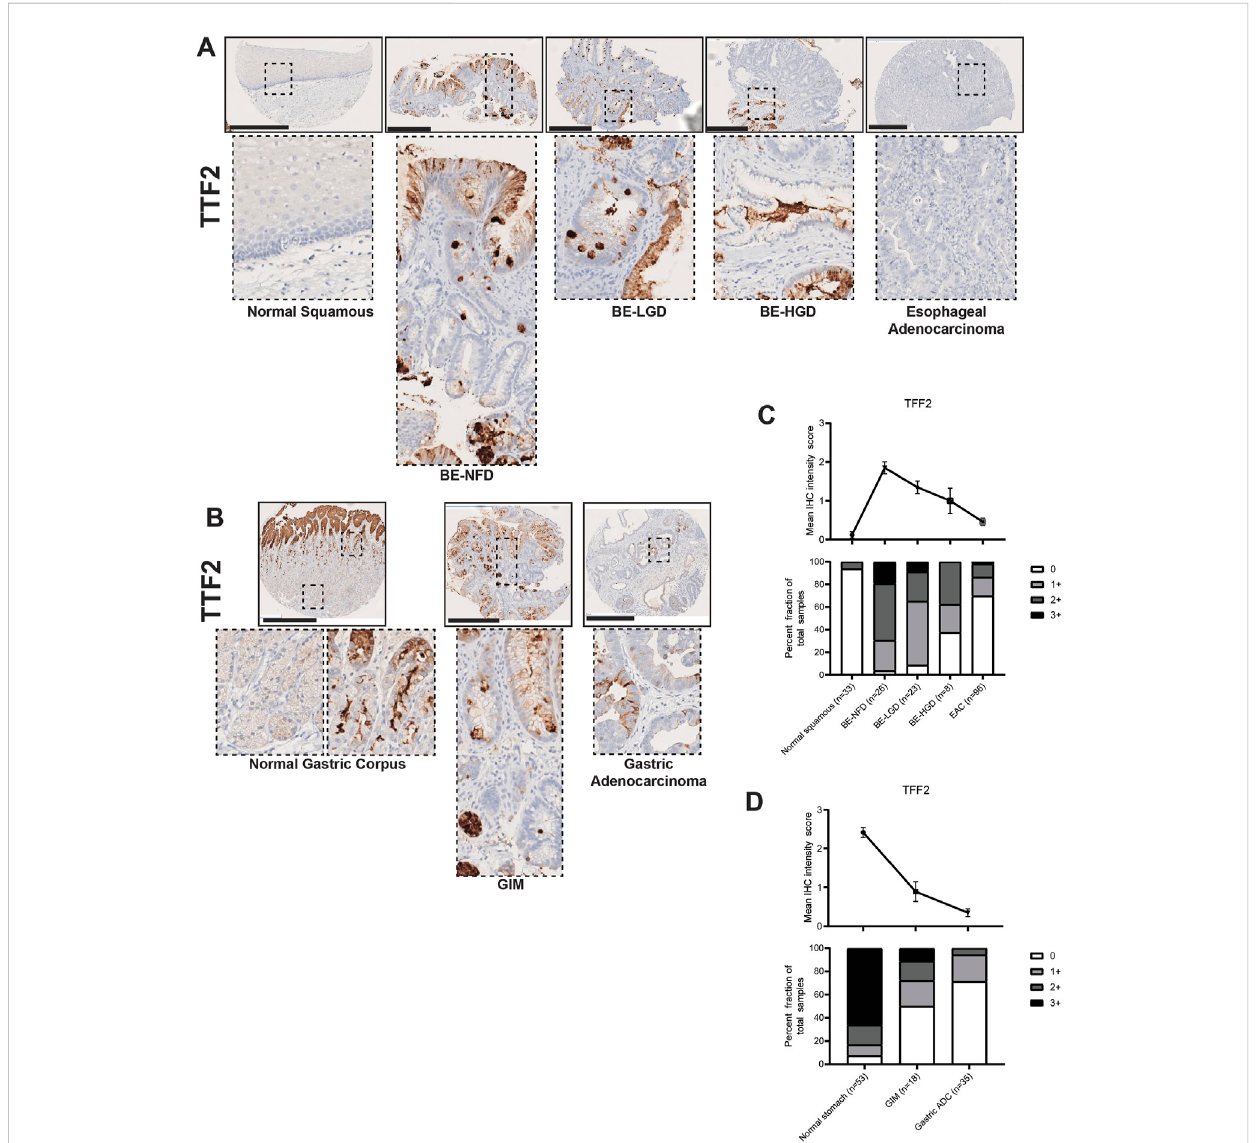
FIGURE 2 TFF2expressioninnormalsquamous-BE-EACandnormalgastricgland-GIM-GAprogressionsequence. (A) ImmunohistochemistryofTFF2staining in human tissue microarray esophageal cases, from left to right: normal squamous, BE-NFD, BE-LGD, BE-HGD, and EAC. (B) Immunohistochemistry of TFF2 staining in human tissue microarray gastric cases, from left to right: normal gastric corpus (left inset from base of the glands, right inset from the surfaceoftheglands),GIM,andGA.Allscalebars,500 μ m. (C) Analysisofthehumanesophagealtissuemicroarraywithnormalsquamous,BE-NFD, BE-LGD, BE-HGD, and EAC tissue cores stained by immunohistochemistry for TFF2. Top: the TFF2 average IHC intensity score of each esophageal phenotype is plotted. For staining intensity, score 0 (undetectable) to 3 (most intense). Bottom: the TFF2 fraction of esophageal tissue cores with each scoreisplotted.Eachphenotype ’ stotaltissue core numberisprovided atthebottomofeachcolumn. (D) Analysis ofthehuman gastrictissue microarray withnormal,GIM,andGAtissuecoresstainedbyimmunohistochemistryforTFF2.Top:theTFF2averageIHCintensity scoreofeachgastricphenotypeis plotted.Forstainingintensity,score0(undetectable)to3(mostintense).Bottom:theTFF2fractionofgastrictissuecoreswitheachscoreisplotted.Each phenotype ’ s total tissue core number is provided at the bottom of each